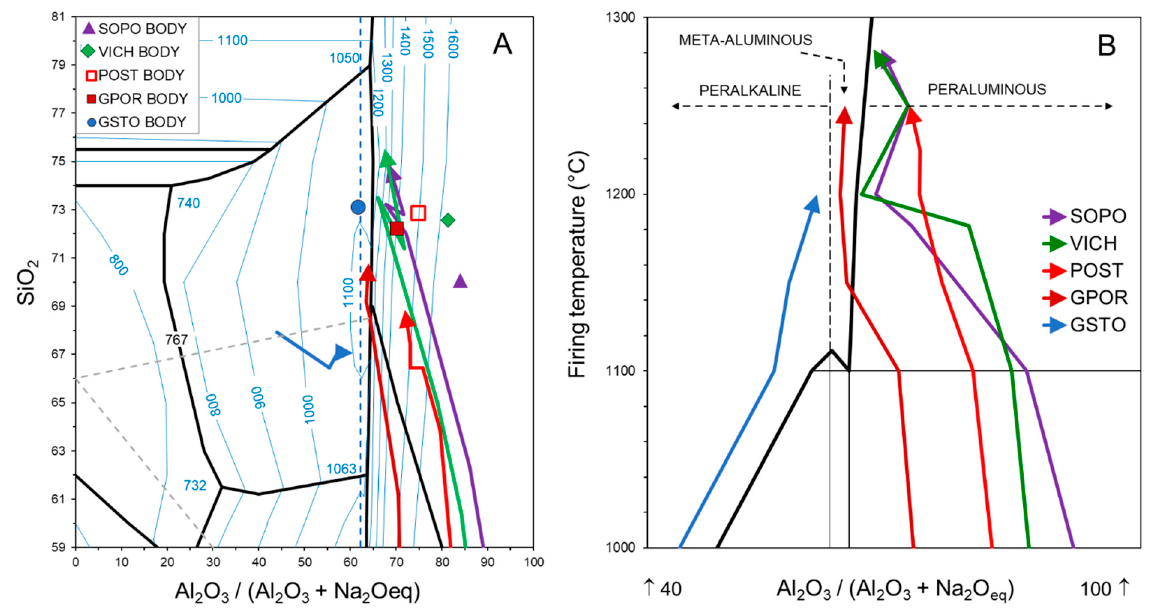
Figure 13. Starting chemical composition of the bodies ( A ) and trends of melts composition in the ternary diagram ( A , B ).